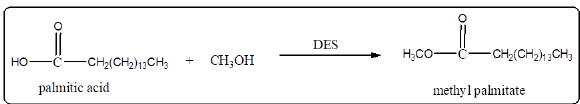
Figure 24: DES catalyzed synthesis of N-phenylphthalimide derivatives. r r See Lobo et al. [96] for detailed reaction components and